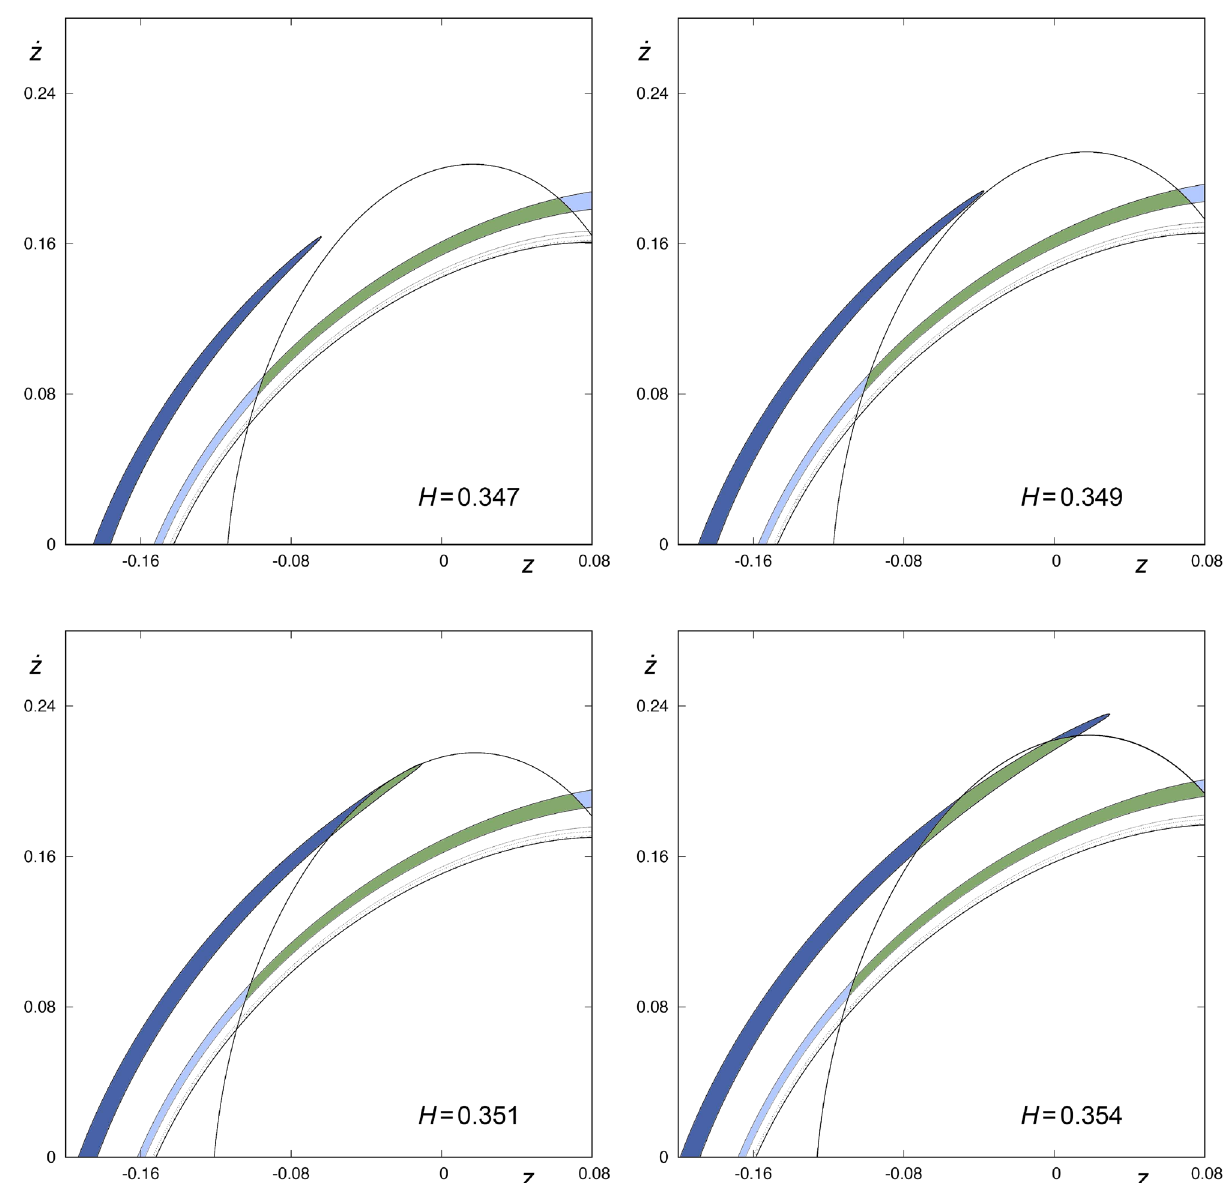
Figure 7. Detail of W s ,4 (φ) and W u ,1 (φ) for H = 0.347, 0.349, 0.351 and 0.354. The area enclosed by W s ,4 (φ) is colored in green or blue, depending on whether it is contained in the area enclosed by W u ,1 (φ) or not, respectively. Orbits starting in the green colored area enter the central part of the galaxy from the infinity and, after intersecting the surface of section r = ¯ r at four points, leave the potential well. This graphic has been generated by using Gnuplot Version 5.2. http:// www. gnupl ot.